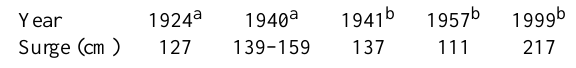
Table 4. Additional historical